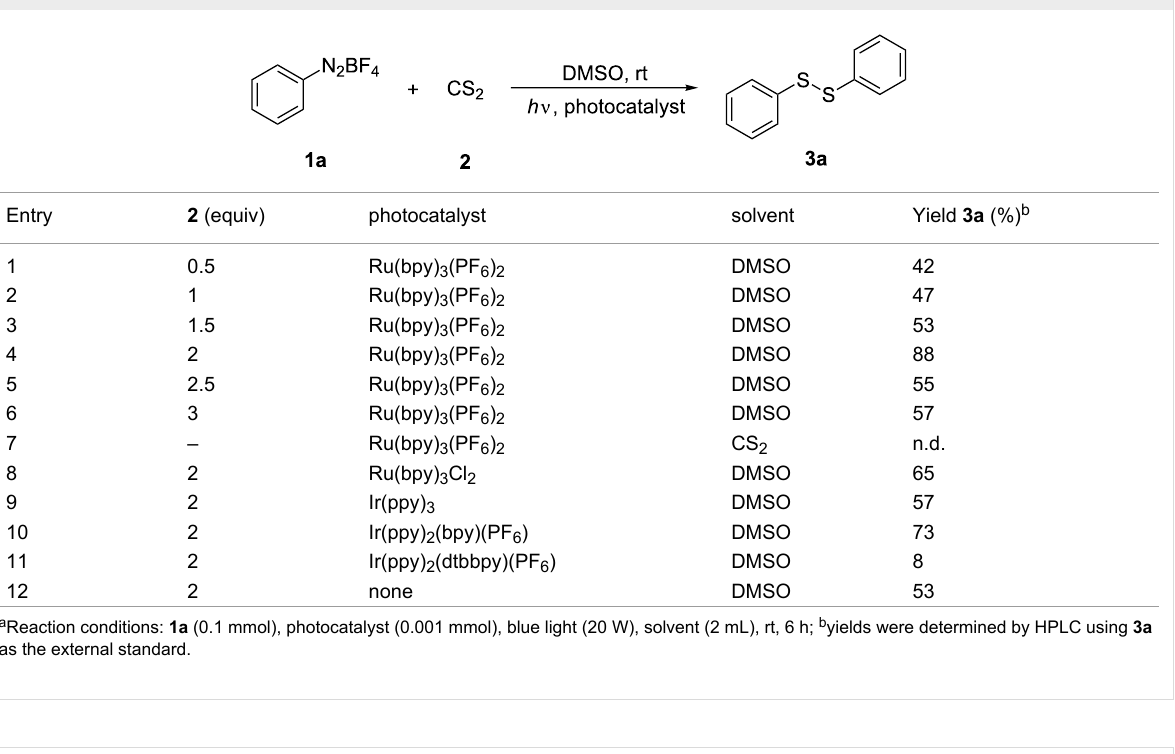
Table 3: Screening of photocatalysts for the visible light-mediated coupling of benzenediazonium tetrafluoroborate ( 1a ) and CS 2 ( 2 ).